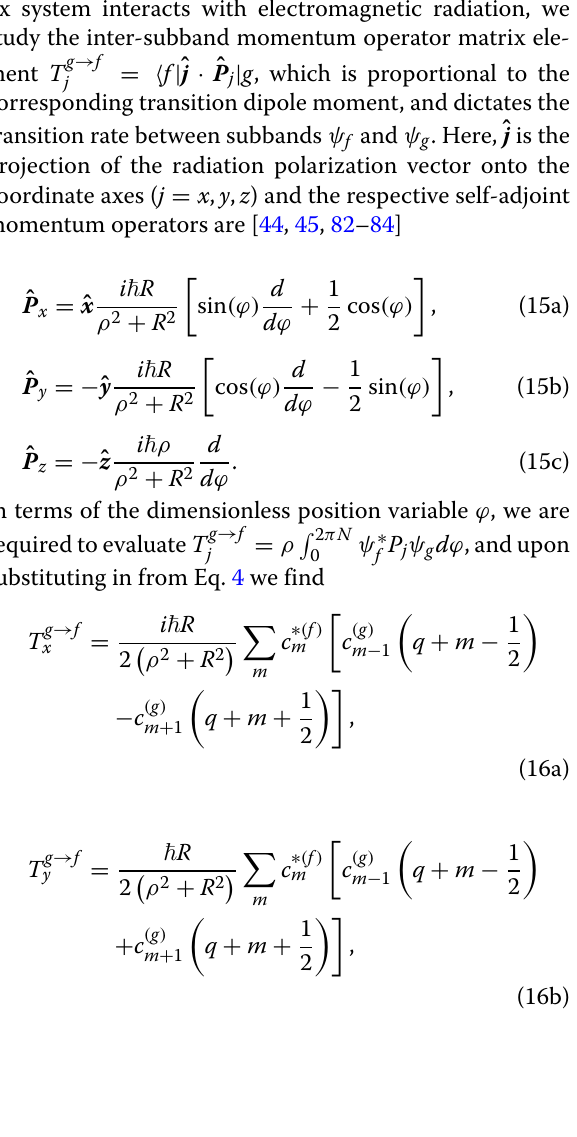
curve through to the solid blue curve). The parameters are